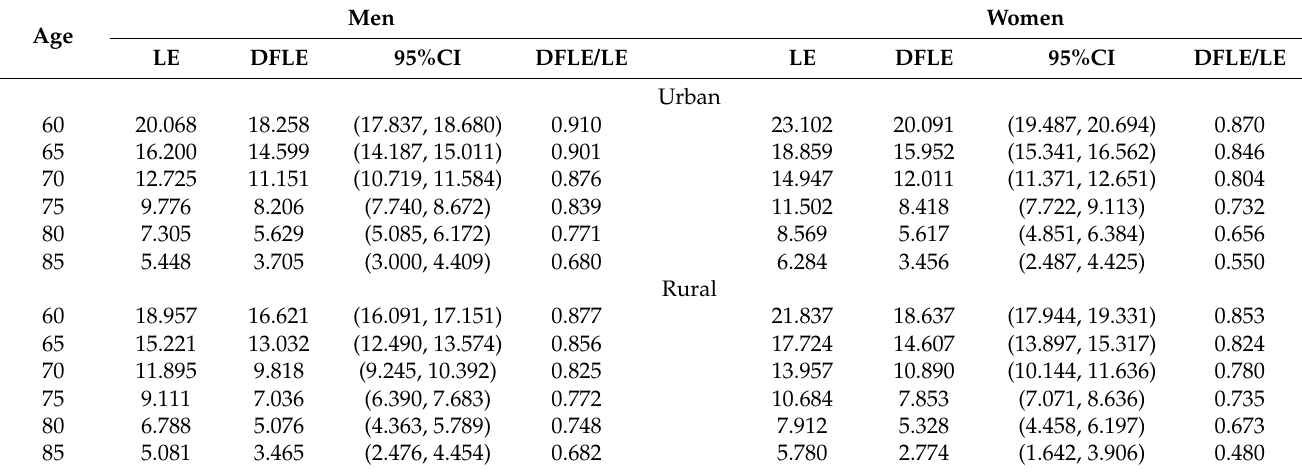
Figure 2 shows the trend of DFLE/LE for men and women in urban and rural areas. The DFLE/LE of 60-year-old urban men is 91.0%, and that of urban women is 87.0%, while the DFLE/LE of 60-year-old rural men is 87.7% and that of rural women of the same age is 85.3%. The DFLE/LE of 85-year-old urban men is 68.0%, and that of urban women is 55.0%, while the DFLE/LE of 85-year-old rural men is 68.2% and that of rural women is 48.0%. Both urban and rural men’s DFLE/LE are higher than the women’s at all ages. The ratio of urban men is always higher than that of rural men (except at age 85). For women, the ratio of urban areas is higher than that of rural areas (except at ages 75 and 80).